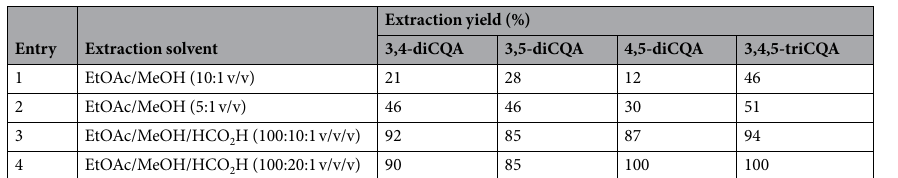
Table 1. Extraction yield of CQAs from the [C 4 mim]Cl